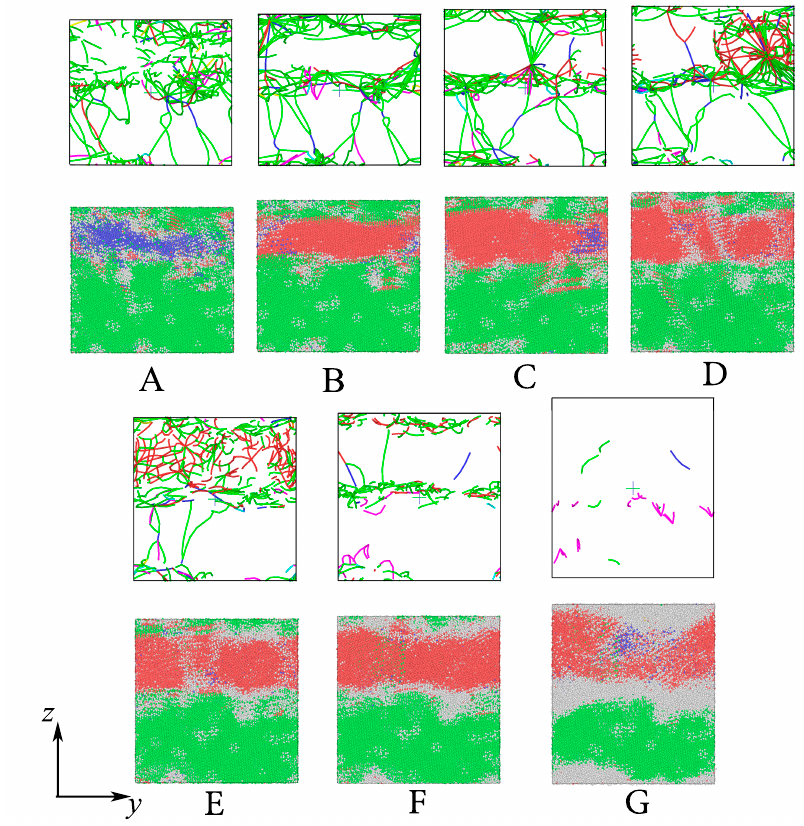
Figure 7. Snapshots of the structure in accordance with stress–strain curve shown in Figure 5 for tension after stage III. All atoms are colored by the CNA parameter, where HCP atoms are red, FCC atoms are green, BCC atoms are blue, and other atoms are